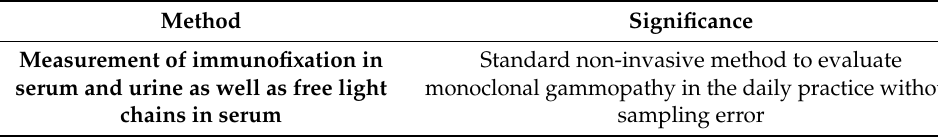
Table 1. Methods to detect, characterize and quantify the